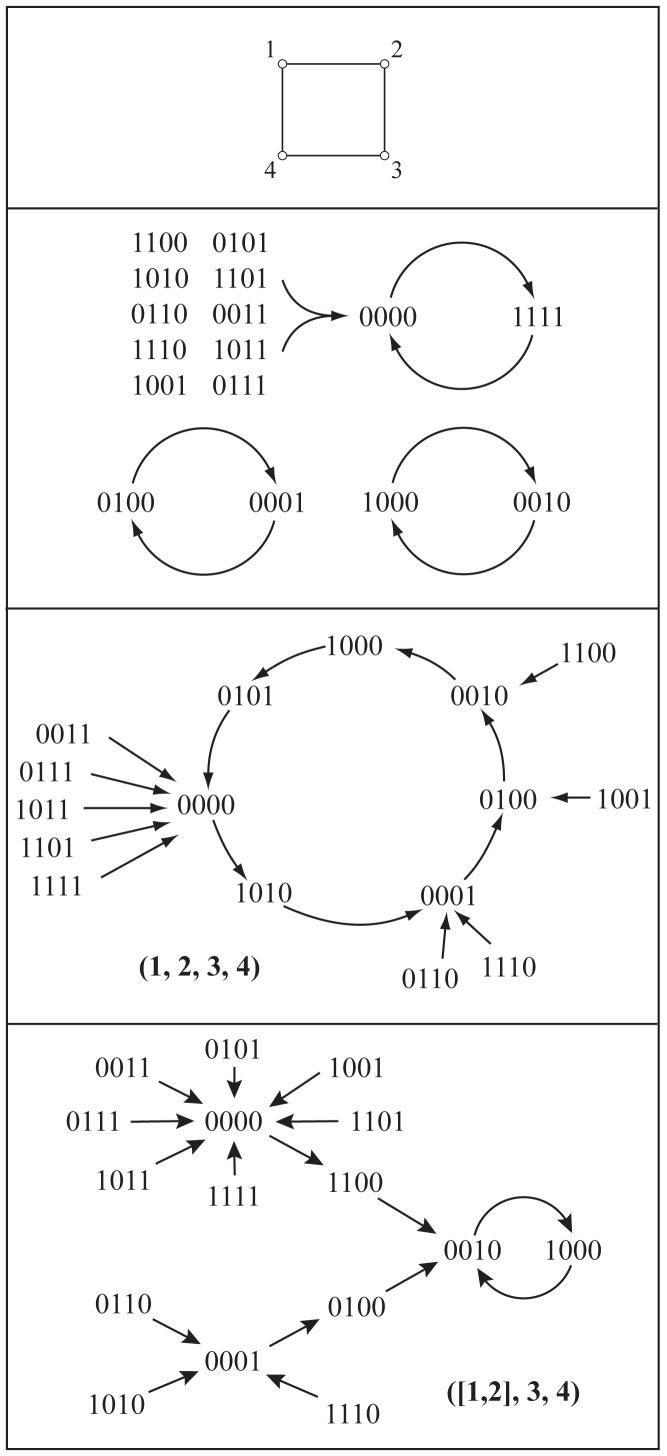
Phase spaces for three GDSs.The bidirected graph X = Circle4 (top), and the phase spaces of the synchronous GDS; a sequential GDS with update permutation π = (1,2,3,4); and a block sequential GDS with block permutation π
B = ([1, 2],3,4). All vertices use the nor function.